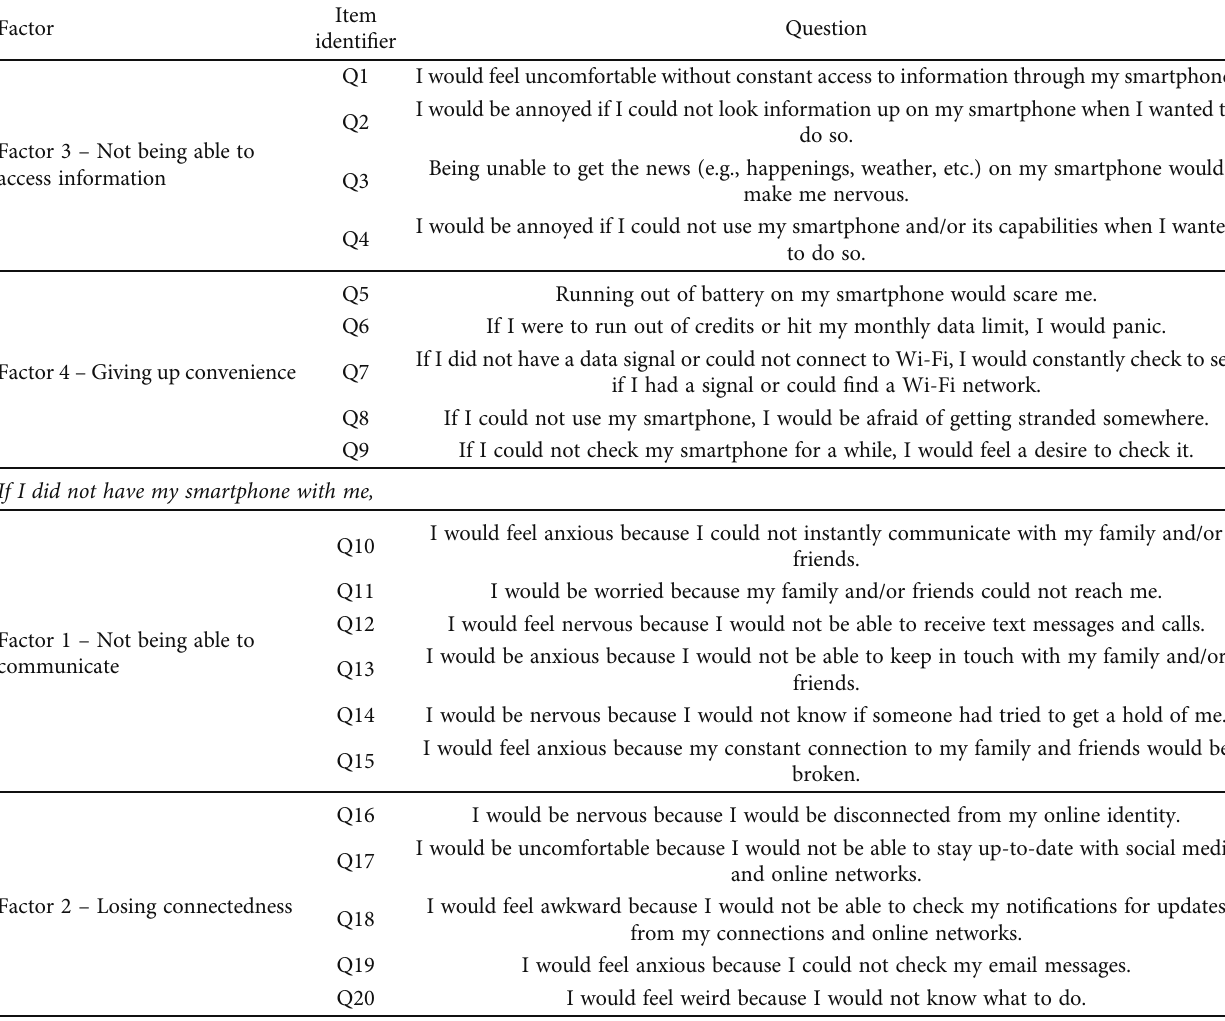
Table 4: Nomophobia questionnaire in English